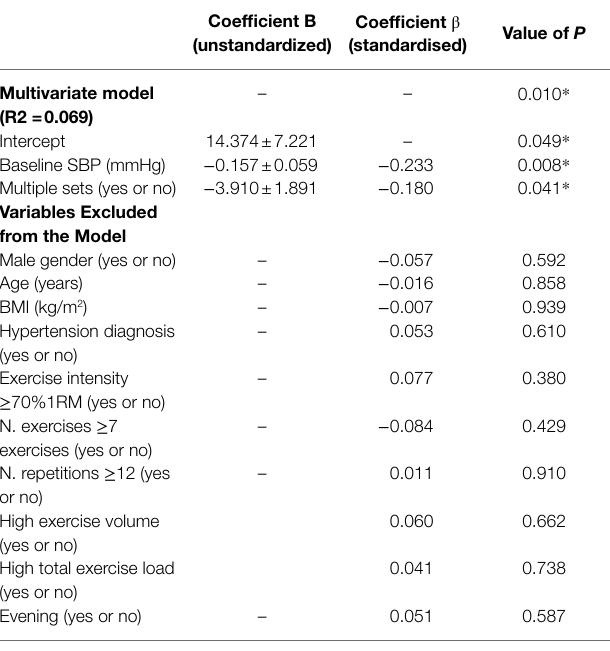
TABLE 3 | Multiple linear regression assessing predictors of post-dynamic resistance exercise hypotension for systolic blood pressure (SBP). Coefficient B Coefficient β Value of P (unstandardized) (standardised) Multivariate model (R2 = 0.069)